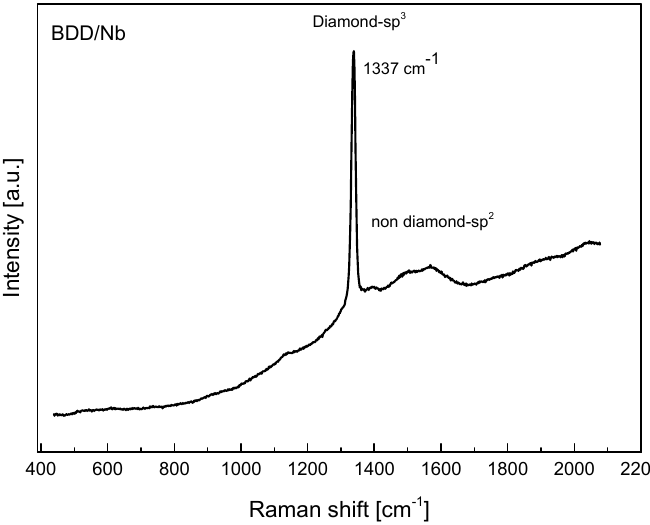
Figure 2. Raman spectrum for the low-doped-BDD / Nb electrodes (thin film of boron-doped diamond (BDD) coated on Nb substrate), the crystalline BDD peak is observed at 1337 cm − 1